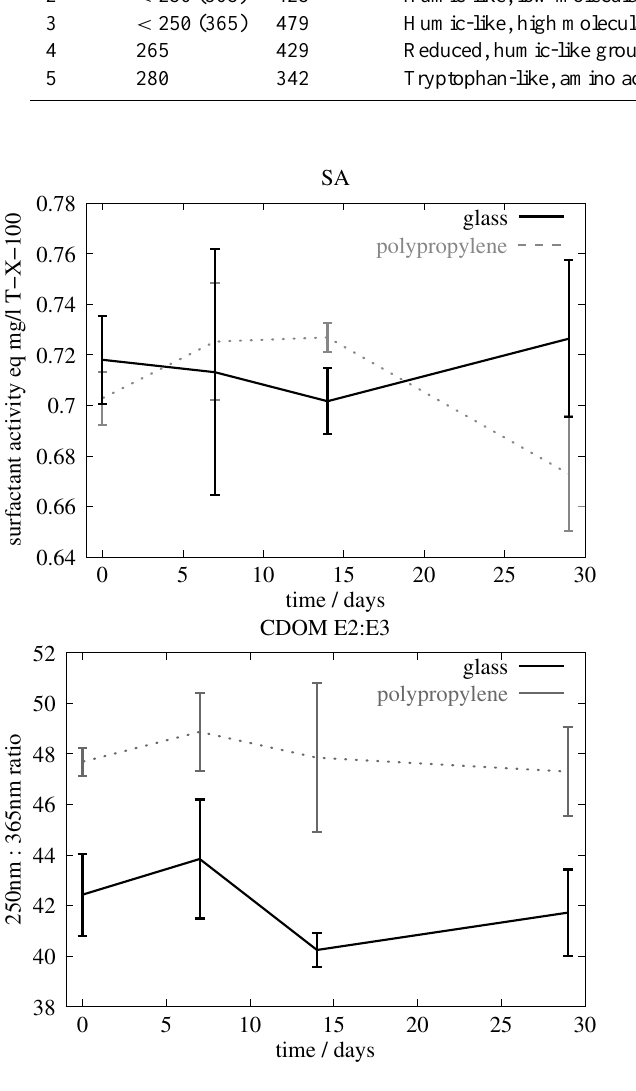
(1000 rpm). Alternating voltage scans of 10 mV at 75 Hz pro- duced a current which was measured. Each response was corrected for the added NaCl solution and expressed as an equivalent T-X-100